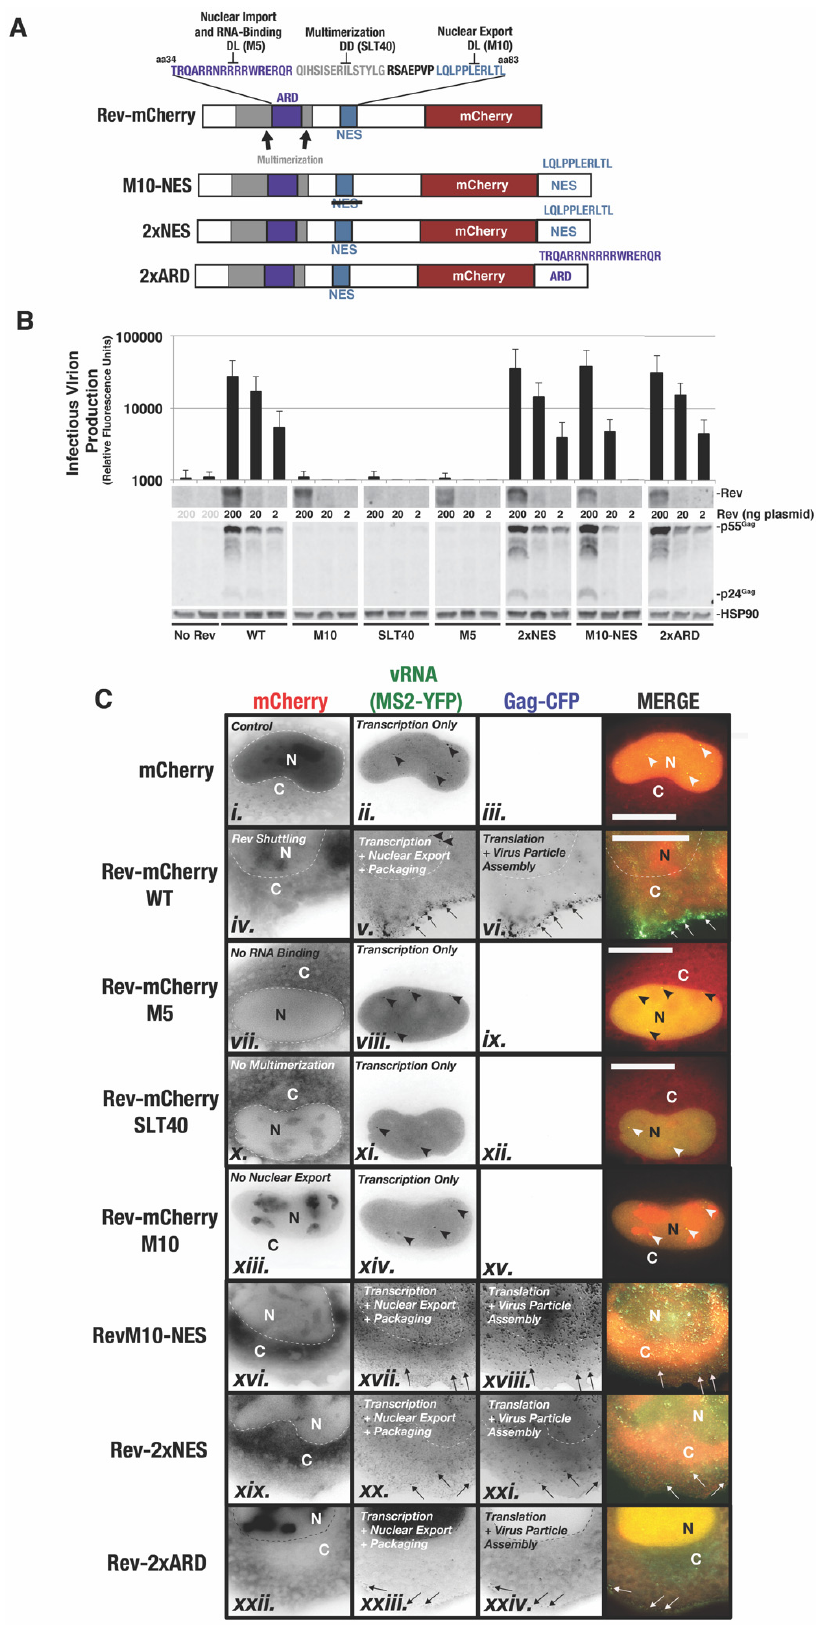
Figure 5. Rev-mCherry functional mutants and trafficking variants used to test the HIV RGB strategy. ( A ) Depiction of Rev-mCherry fusion protein and key functional domains. The arginine-rich